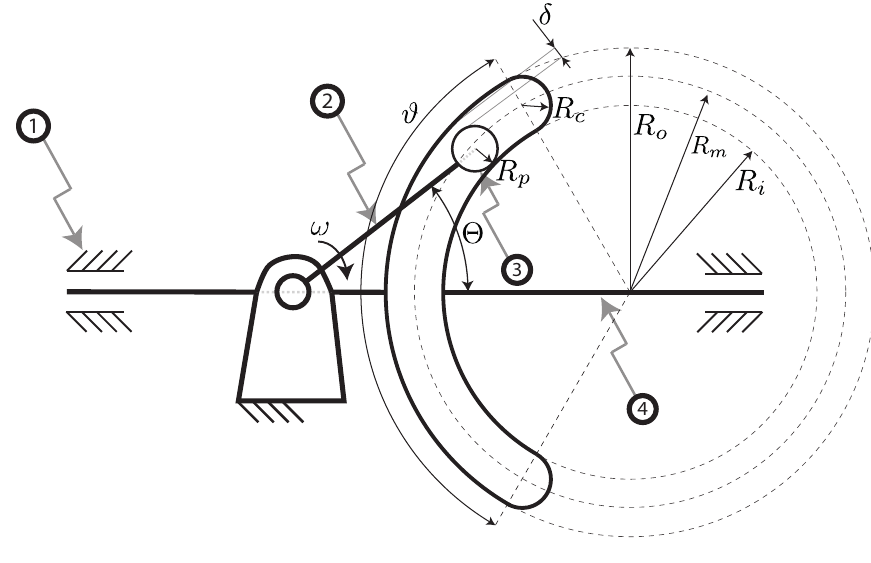
Figure 8. Scotch-yoke linkage.